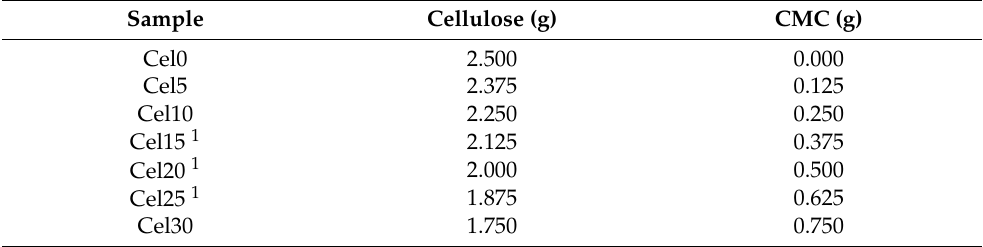
Table 2. Quantities of cellulose and CMC added to NaOH–urea in order to fabricate a bead. Sample Cellulose